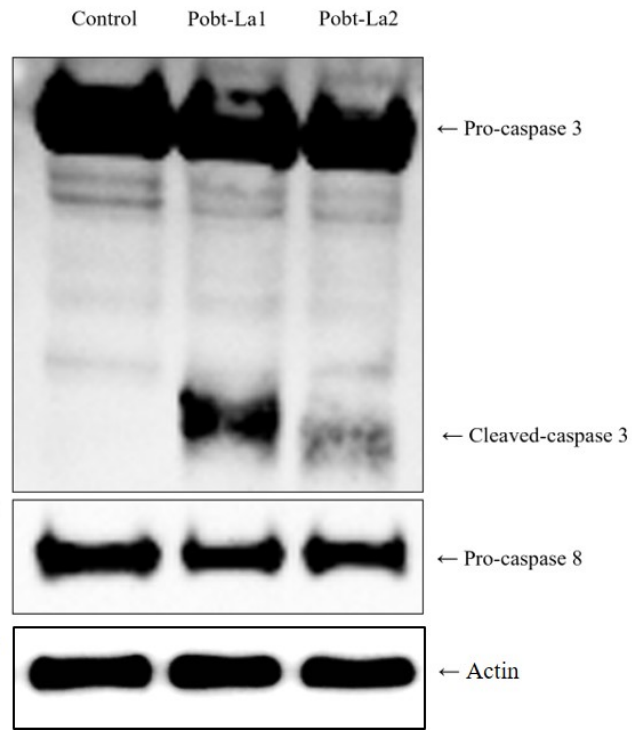
Figure 4. Expression of caspase-3 and 8 proteins in HT-29 cells treated with Pobt-La.